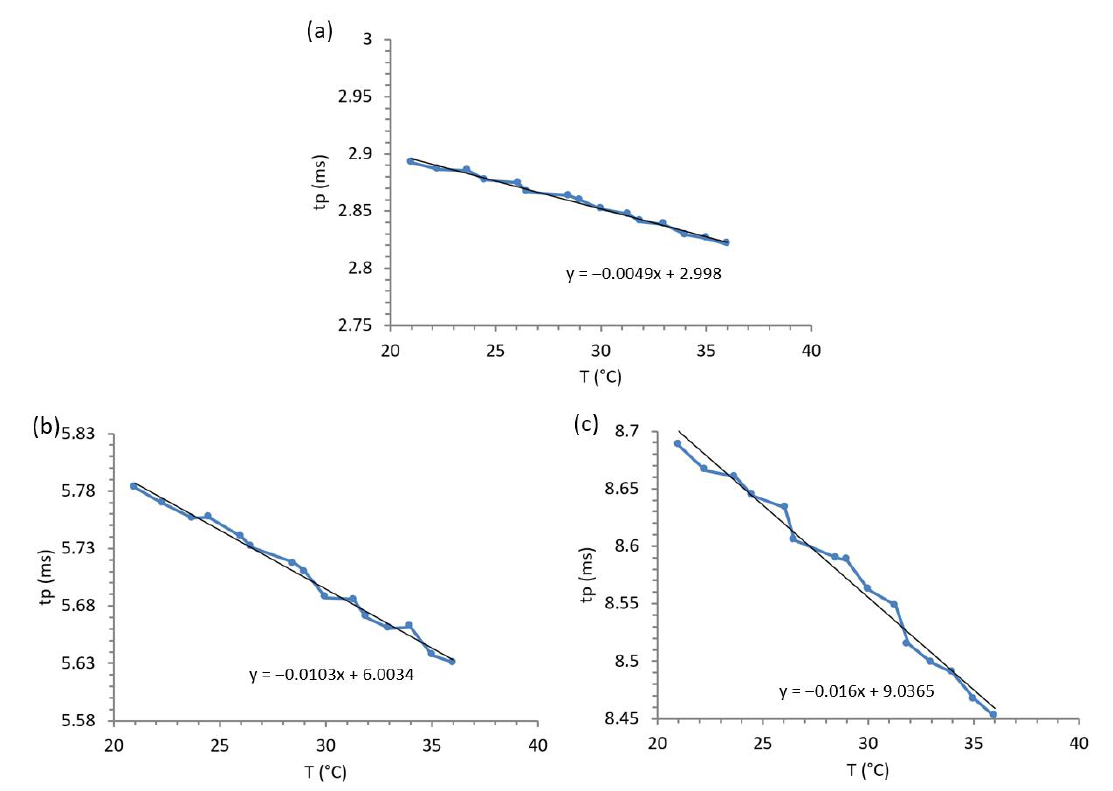
Figure 12. Graphs of propagation time depending on air temperature, along with the trend line and